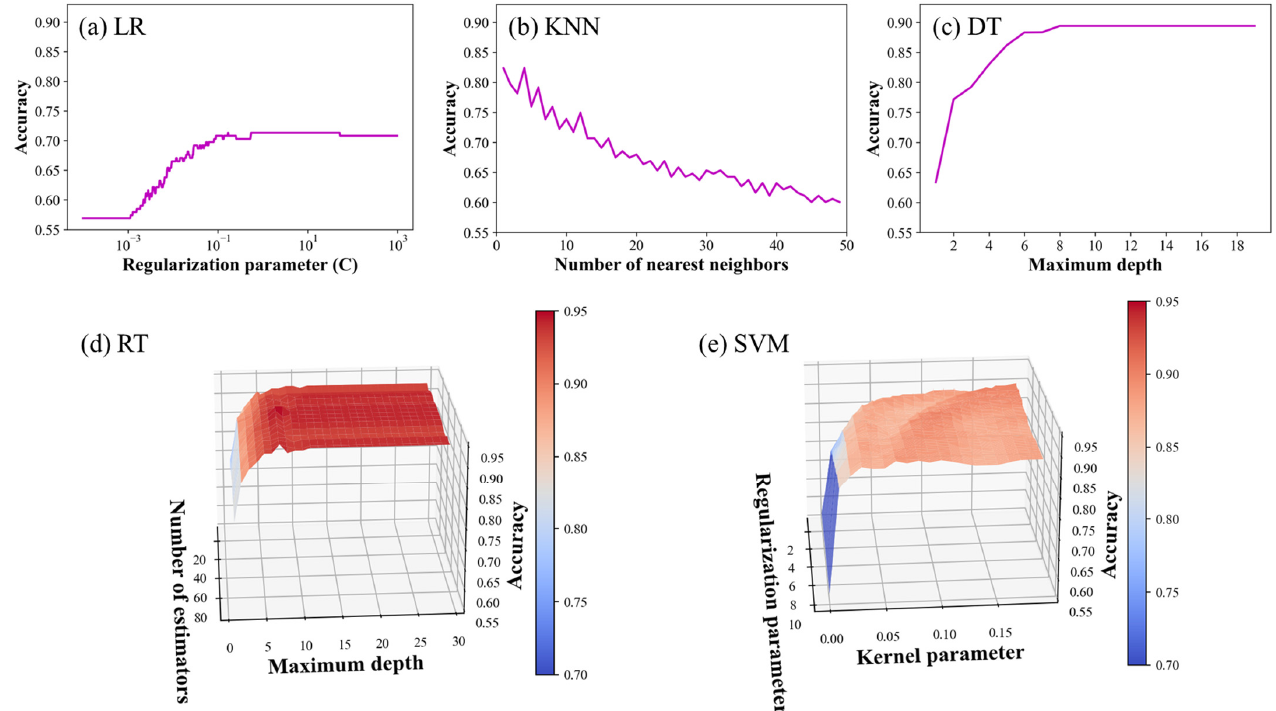
Figure 6. Hyperparameter optimization using grid search combined with ten ‐ fold cross ‐ validation for ( a ) LR, ( b ) KNN, ( c ) DT, ( d ) RT, and ( e ) SVM. The horizontal axis depicts the hyperparameters, and the vertical axis depicts the cross ‐ validation accuracy. The color bars in ( d , e ), too, represent the cross ‐ validation accuracy. The best hyperparameters are summarized in Table 1.